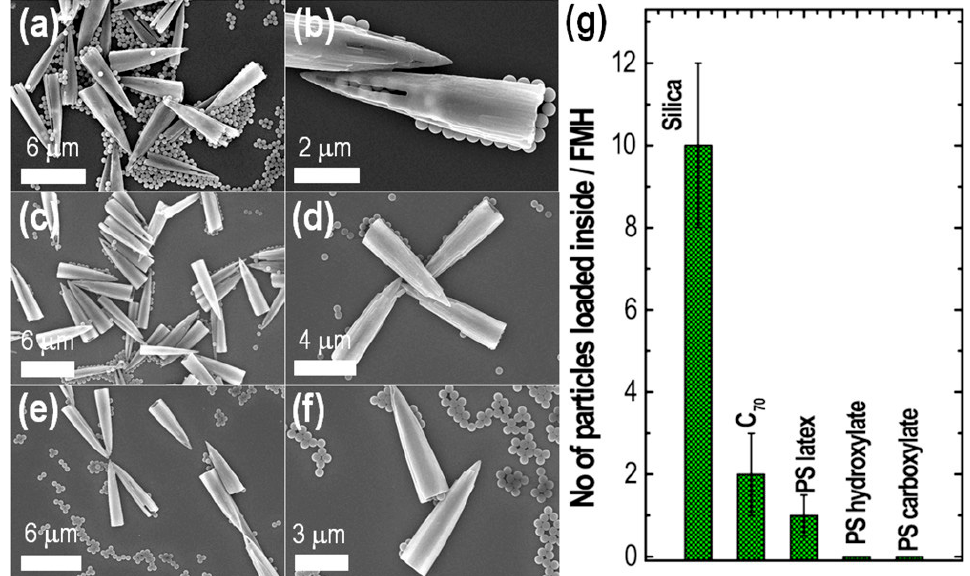
Figure 9. SEM observations showing the different loading capacities of fullerene microhorns (FMHs) toward ( a , b ) silica particles, ( c , d ) polystyrene (PS) latex particles, and ( e , f ) PS carboxylate particles. ( g ) Comparison of the different particles loaded inside the hollow space per FMH. Reproduced from [122] with permission from the American Chemical Society, copyright 2019.